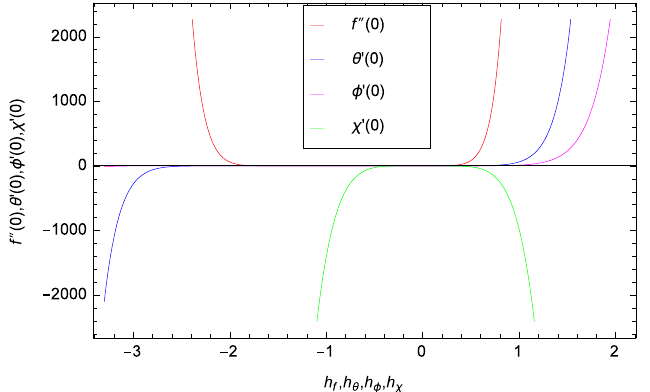
Figure 2. h -curves for f ( ζ ) , θ ( ζ ) , φ ( ζ ) , χ ( ζ )